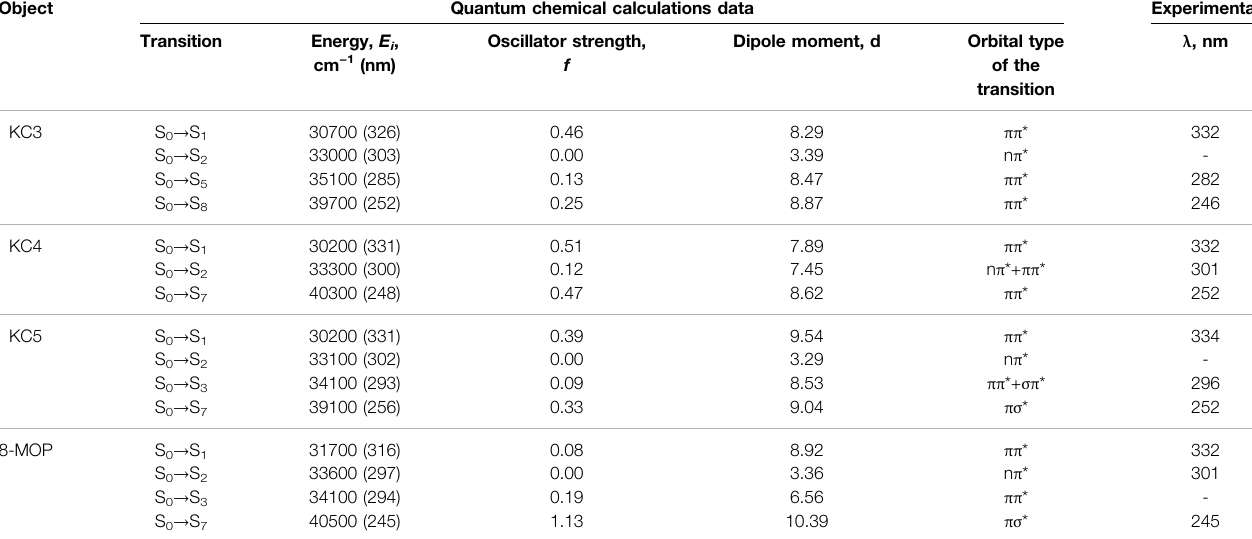
TABLE 1 | Singlet-Singlet absorption spectra of several compounds. Object